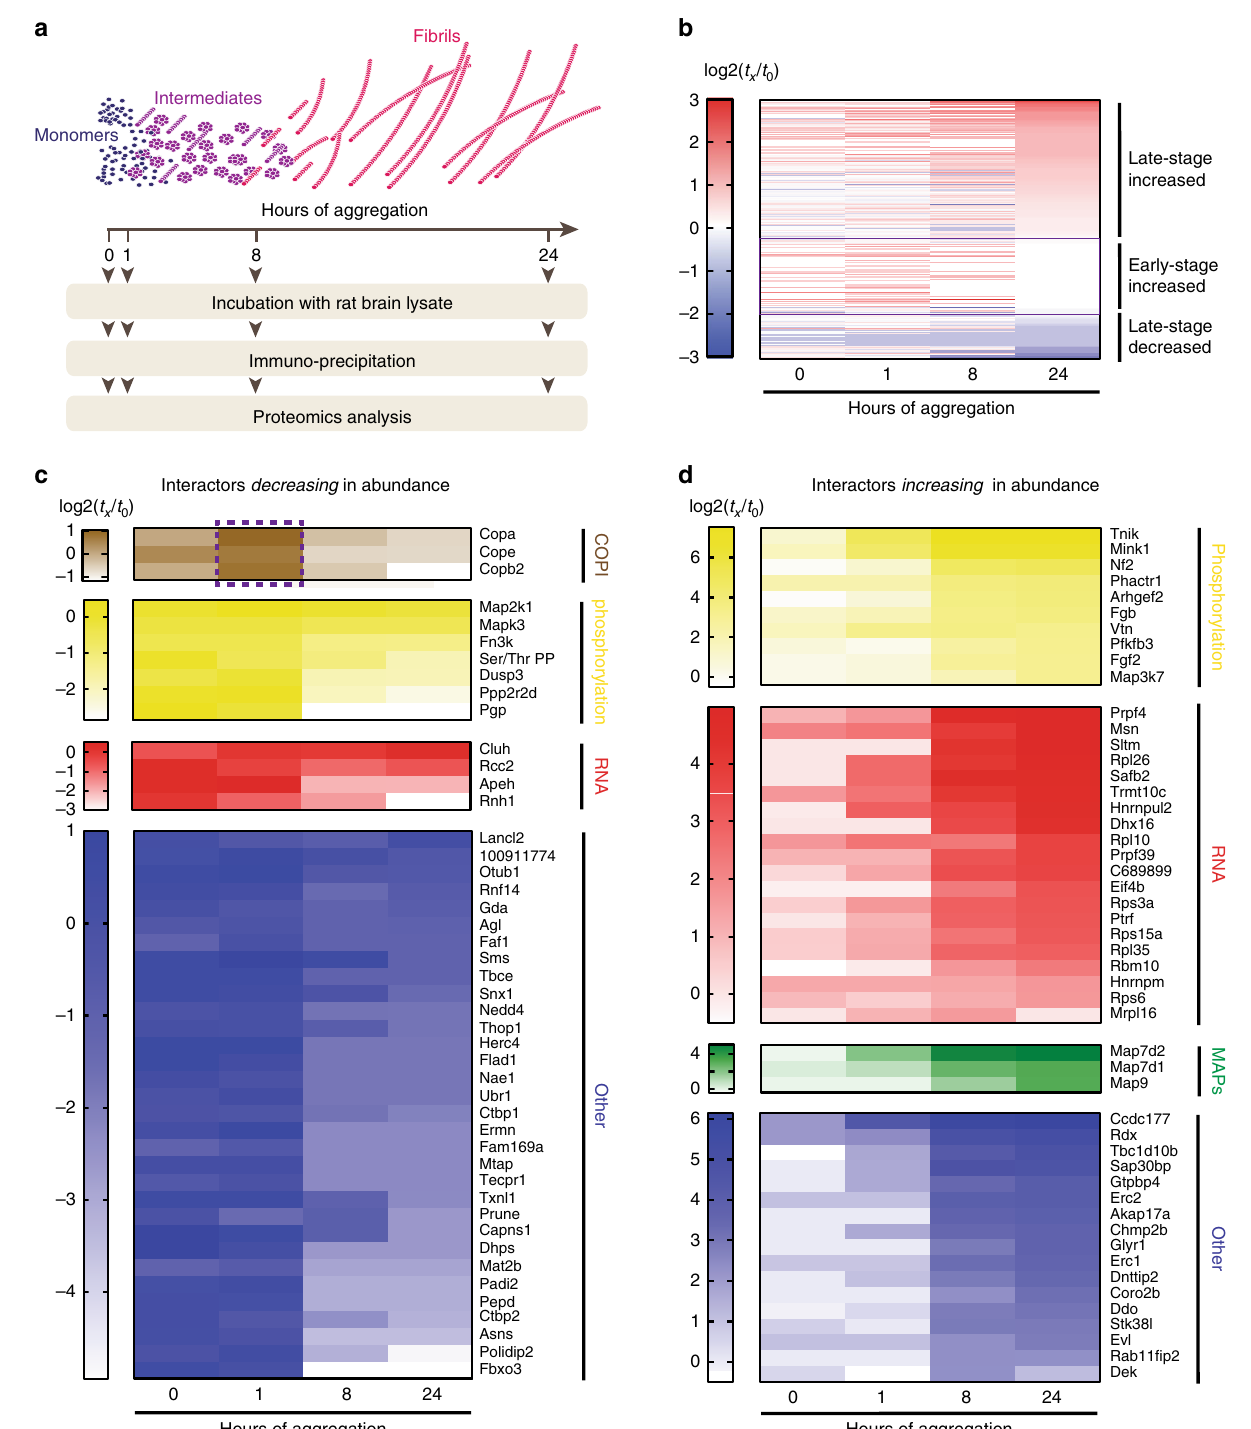
Fig. 2 Tau interactome rewires during aggregation. a Experimental setup to highlight interactome changes upon Tau aggregation. b Heat map of MS-identi fi ed proteins of Tau-RD* aggregates (0, 1, 8, and 24 h of aggregation). Heatmap shows relative enrichment of different time points ( t x ) compared to monomeric Tau-RD* without heparin ( t 0 − ). Interactors are sorted by trend (late-stage decreased, early-stage increased, late-stage increased). c Heat map showing an unbiased selection of Tau-RD* lost proteins (decreasing in abundance) upon aggregation, sorted by colored functional clusters (GO-term analysis). Dashed purple box highlights interactors increasing in abundance at 1 h, then decreasing as aggregation proceeds. See also Supplementary Data 1. d Heat map showing an unbiased selection of Tau-RD* sequestered proteins (increasing in abundance) upon fi bril formation, sorted as for c . See also Supplementary Data